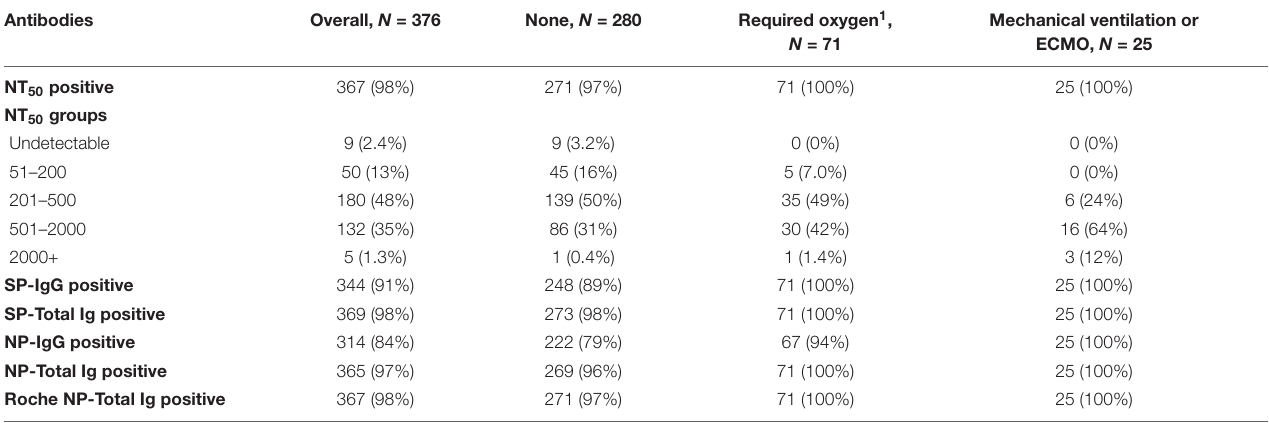
TABLE 2 | Distribution of NT 50 and titers of antibodies against NP and SP antigens for among participants overall and with stratification by requirement of oxygen support ( N = 376). Antibodies Overall, N = 376 None, N = 280 Required oxygen 1 ,